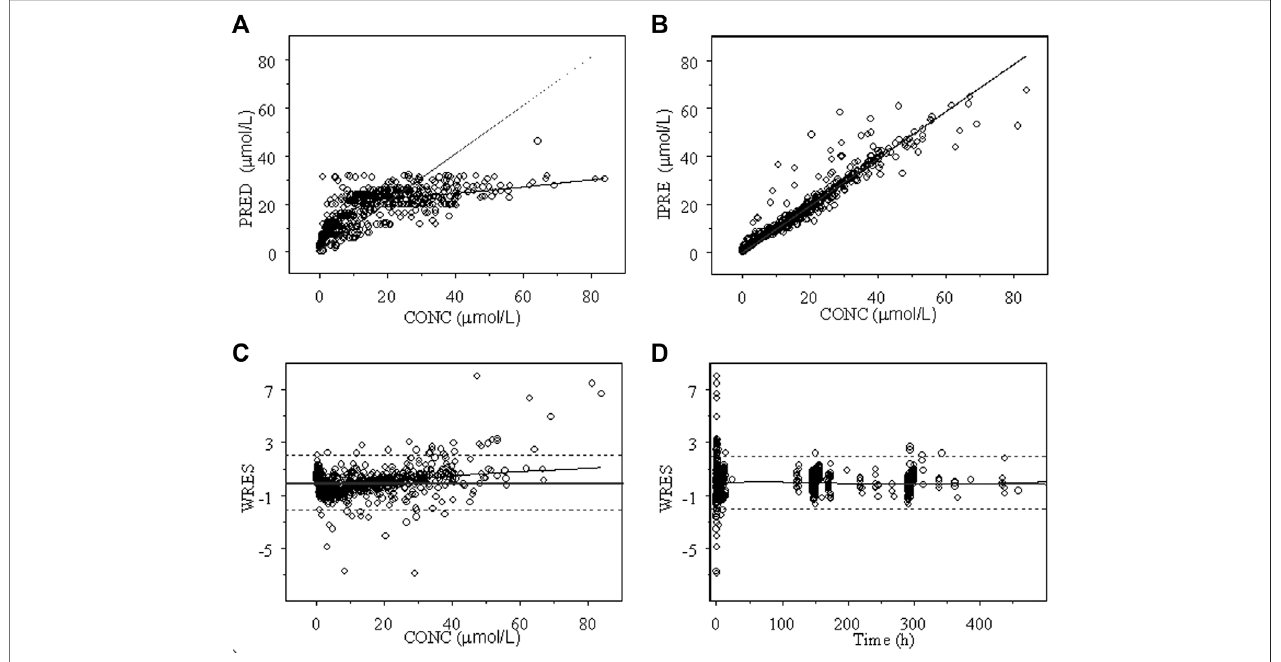
FIGURE 2 | Goodness of fi t of INH from the fi nal integrated PPK model in Chinese healthy subjects and tuberculosis patients. (A) Population predicted concentration (PRED) vs. observed concentration (CONC); (B) individual predicted concentration (IPRE) vs. DV; (C) weighted residual error (WRES) vs. CONC; (D) WRES vs.